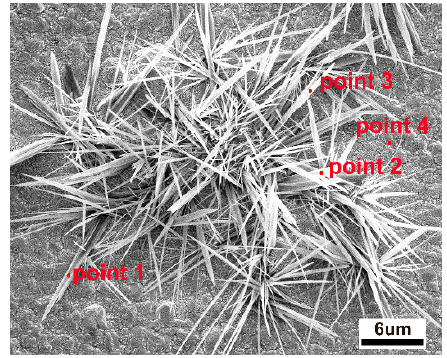
Figure 4. SEM images of different electrodes morphologies synthesized under corresponding bias potentials.